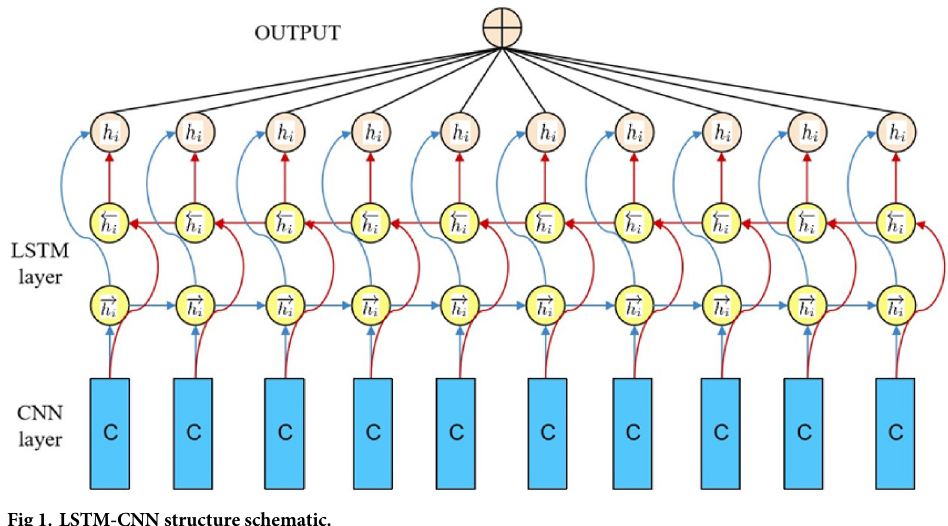
Fig 1. LSTM-CNN structure